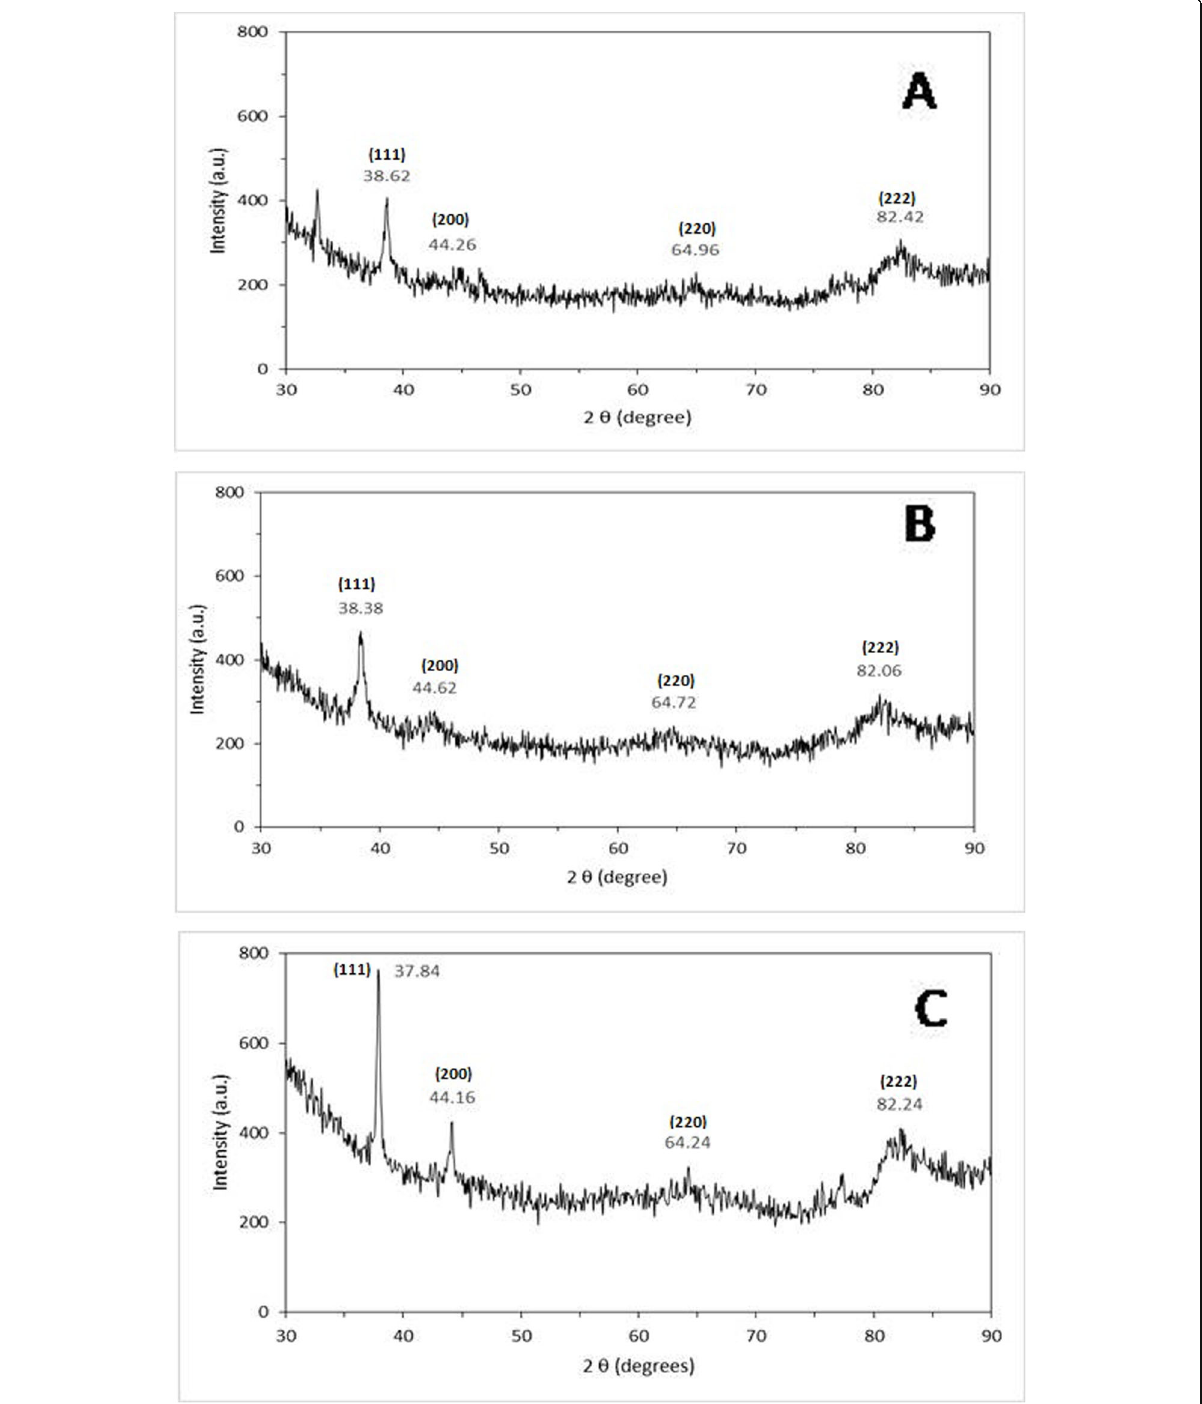
Fig. 3 a – c The XRD pattern of biosynthesized AgNPs. a P-AgNPs. b Q-AgNPs. c